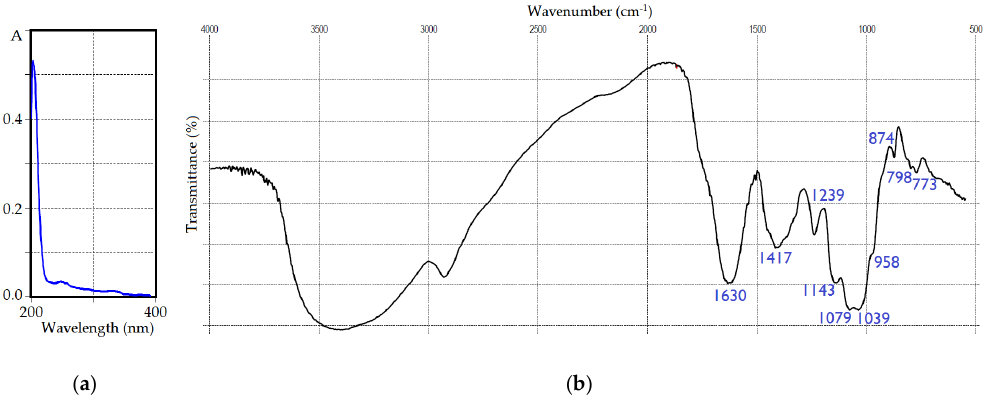
Figure 2. UV ( a ) and FTIR spectra ( b ) of IRP polysaccharide. Gel permeation chromatography (Sephacryl 400HR) indicated the heterogeneity of IRP (Figure 3a), and then five homogenic fraction were isolated. Three polymers with low retention were IRP-1, IRP-2, and IRP-3 with molecular weights of 1520, 1150, and 820 kDa, respectively (Table 2). The IRP-1 polymer was characterized by the predominance of glu- cose, galactose, and mannose in the ratio of 6.1:1.2:1, while IRP-2 also contained glucose, galactose, and mannose as the main monosaccharides but in a different ratio of 2.9:2.2:1. For IRP-3, an increased content of xylose (15.9 mol%) was noted; the ratio of the main monosaccharides galactose, mannose, and xylose was 3.6:1.2:1. The dominant polymer, IRP-4, with a 71.7% yield of IRP weight, had a molecular weight of 148 kDa and was a heteropolysaccharide containing galactose, mannose, and glucose as the main monosaccharides in a ratio of 4.2:1.4:1. The level of minor monosac- charides accounted for no more than 4.5 mol%. The polymer IRP-5 with the lowest molec- ular weight (110 kDa) was a glucan with a glucose content of 81.7 mol%. Thus, the com- plex of water-soluble polysaccharides of I. rheades mycelium is a mixture of predominantly glucans (IRP-1, IRP-2, and IRP-5) and galactans (IRP-3 and IRP-4) with varied molecular weights. ( a )